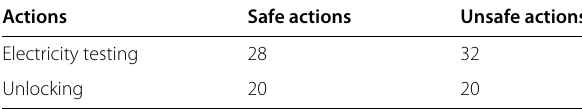
classification is carried out through softmax layer. To ensure fairness, the network model uses the same hyper parameters as shown in Fig. 5. The experimental results are shown as Fig. 9.